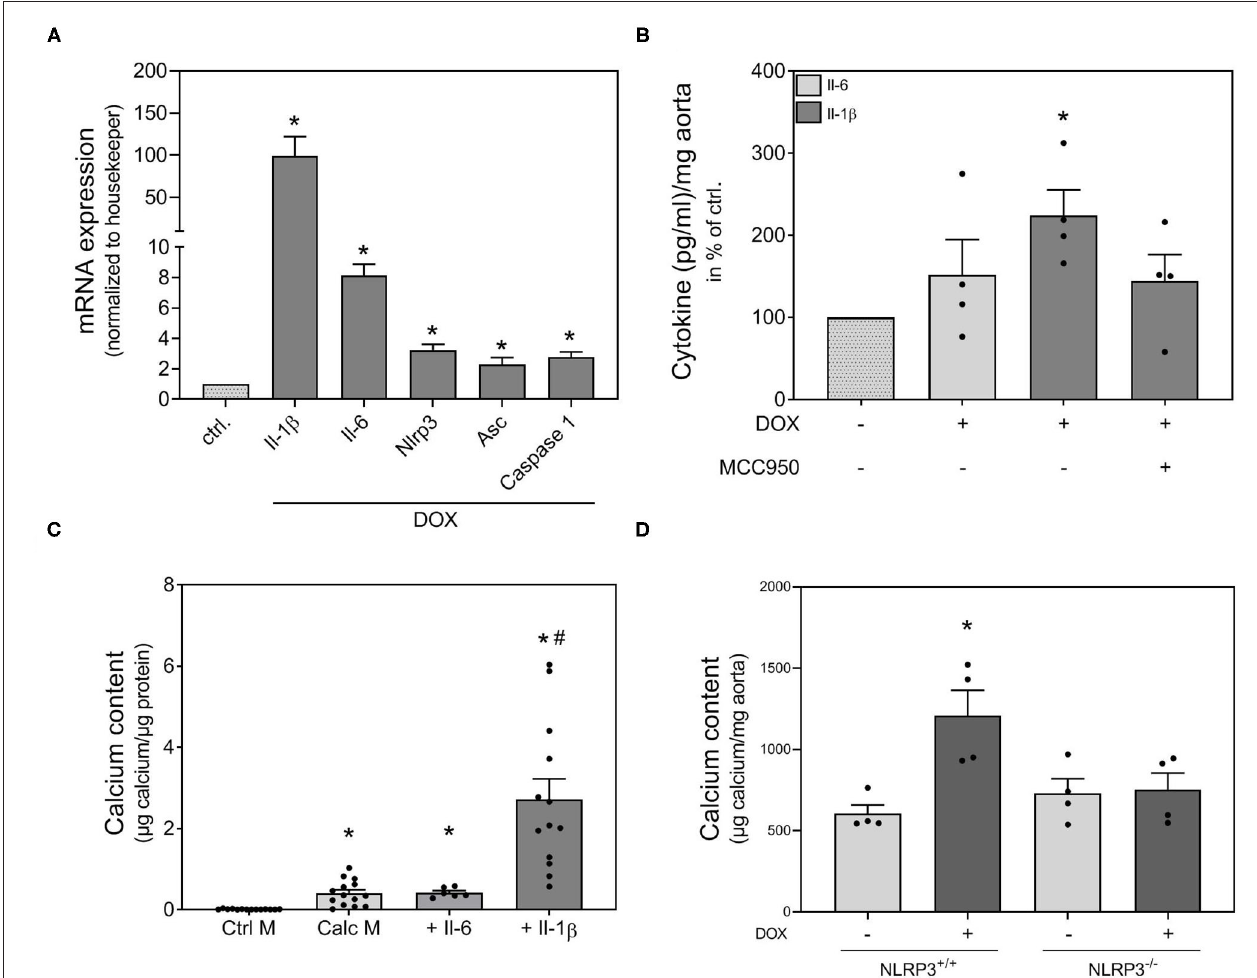
FIGURE 3 | Involvement of Nlrp3 in doxorubicin induced calcification. VSMCs (A,C) were stimulated as indicated with 1,000 nmol/l DOX (A) , 100ng/ml Il-1 β (C) and 100ng/ml Il-6 (C) for 48h (A) or 14 d (C) in quiescence medium (A) , control medium (Ctrl. M) (C) or calcification medium (Calc M) (C) . Aortic rings from rats were stimulated in quiescence medium with 1,000 nmol/l DOX and MCC950 (50 µ M) as indicated for 24h (B) . Aortic rings from Nlrp3 − / − mice and respective controls were stimulated for 14 d in calcification medium with DOX (100 nmol/l) as indicated (D) . mRNA expression was measured with quantitative real time PCR (A) . Measured thresholds of the respective targets were normalized to the corresponding threshold of housekeeper gene actin before normalization to control (A) . Protein secretion was assessed with Luminex TM and normalized to aortic weight (mg) (B) . Calcium content was quantified with o -cresolphthalein (C,D) and normalized to protein content ( µ g) (C) or aortic weight (D) . Data represent mean ± SEM, n ≥ 3, * p < 0.05 vs. control, # p < 0.05 vs. Calc